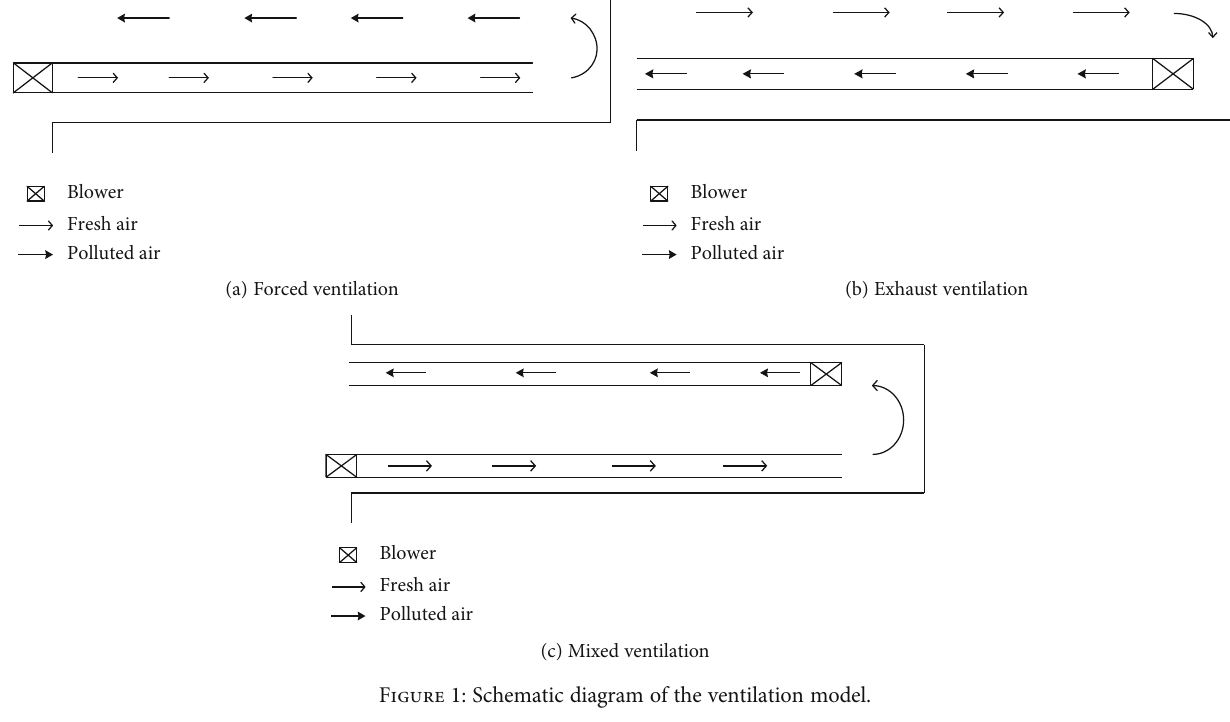
Figure 1: Schematic diagram of the ventilation model.